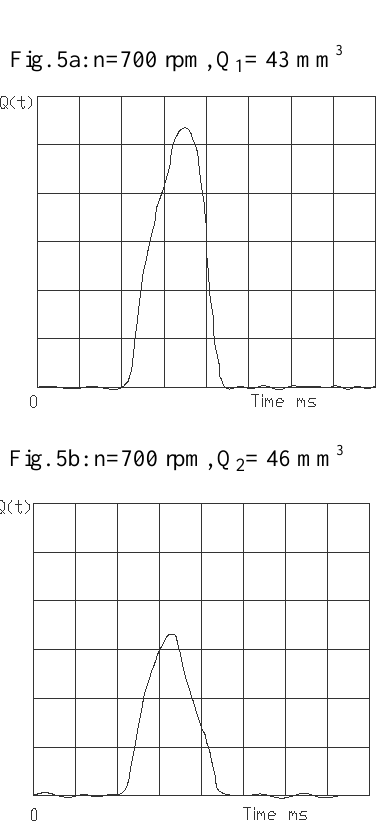
=153 mm 3 per tot